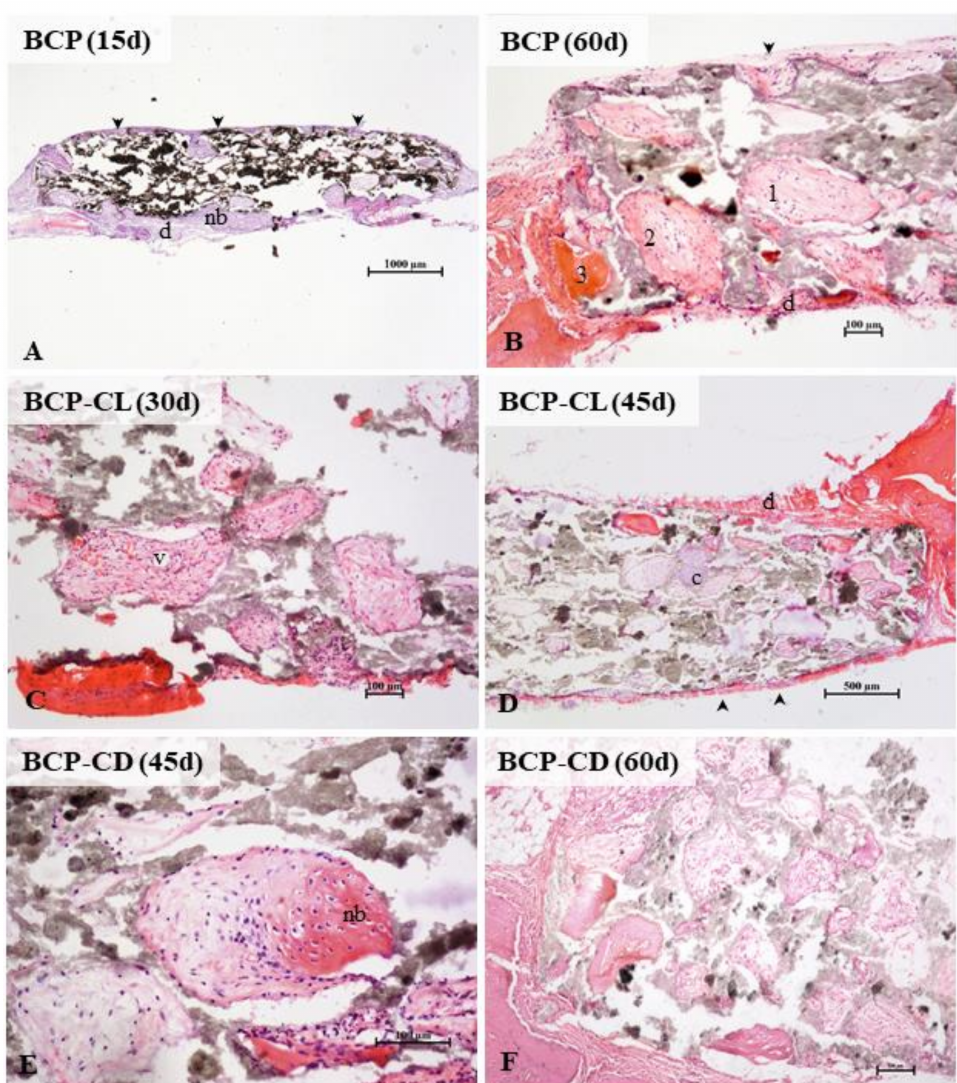
Figure 12. Photomicrographs of critical size defects in rat calvaria after implants with scaffolds of BCP ( A , B ), BCP-CL ( C , D ) and BCP-CD ( E , F ). The animals remained with the implants for 15 ( A ), 30 ( C ), 45 ( D , E ) or 60 ( B , F ) d. The scaffold pores of the three groups studied were filled by cells and blood vessels (v) from the periosteum (arrowhead) and dura mater (d). Intramembranous ossifica- tion, typical of the calvaria, was the main type. Initially, a loose connective tissue filled the pores. A primary bone, with denser fibers, irregularly disposed, was deposited from the margins of the pores, followed by lamellar deposition of bone matrix. In the three groups studied, the presence of pores filled with hyaline cartilage was occasionally observed (c). In ( A ), a panoramic view of a BCP scaffold shows most of the still empty pores and filled peripheral pores. In ( B ) observe the detail of collagen deposition in the pores. The numbers 1, 2, and 3 ( B , C ) indicate the gradation in the ossification process. The pore (1) shows the beginning of densification of the loose connective tissue, in (2) larger collagen fiber deposition in the periphery of the pore (primary bone tissue), and in (3), the pore filled with mature lamellar bone. At 45 ( D , E ) and 60 ( B , F ) d, more central pores presented colonized by connective tissue, but with little lamellar bone formation. In ( E ), the detail of a pore in the process of ossification. BCP = biphasic calcium phosphate; CL = free curcumin; CD = curcumin complexed with cyclodextrin; d = dura mater; nb = new bone; arrow head = periosteum; v = blood vessel; c = cartilage. Staining: hematoxylin and